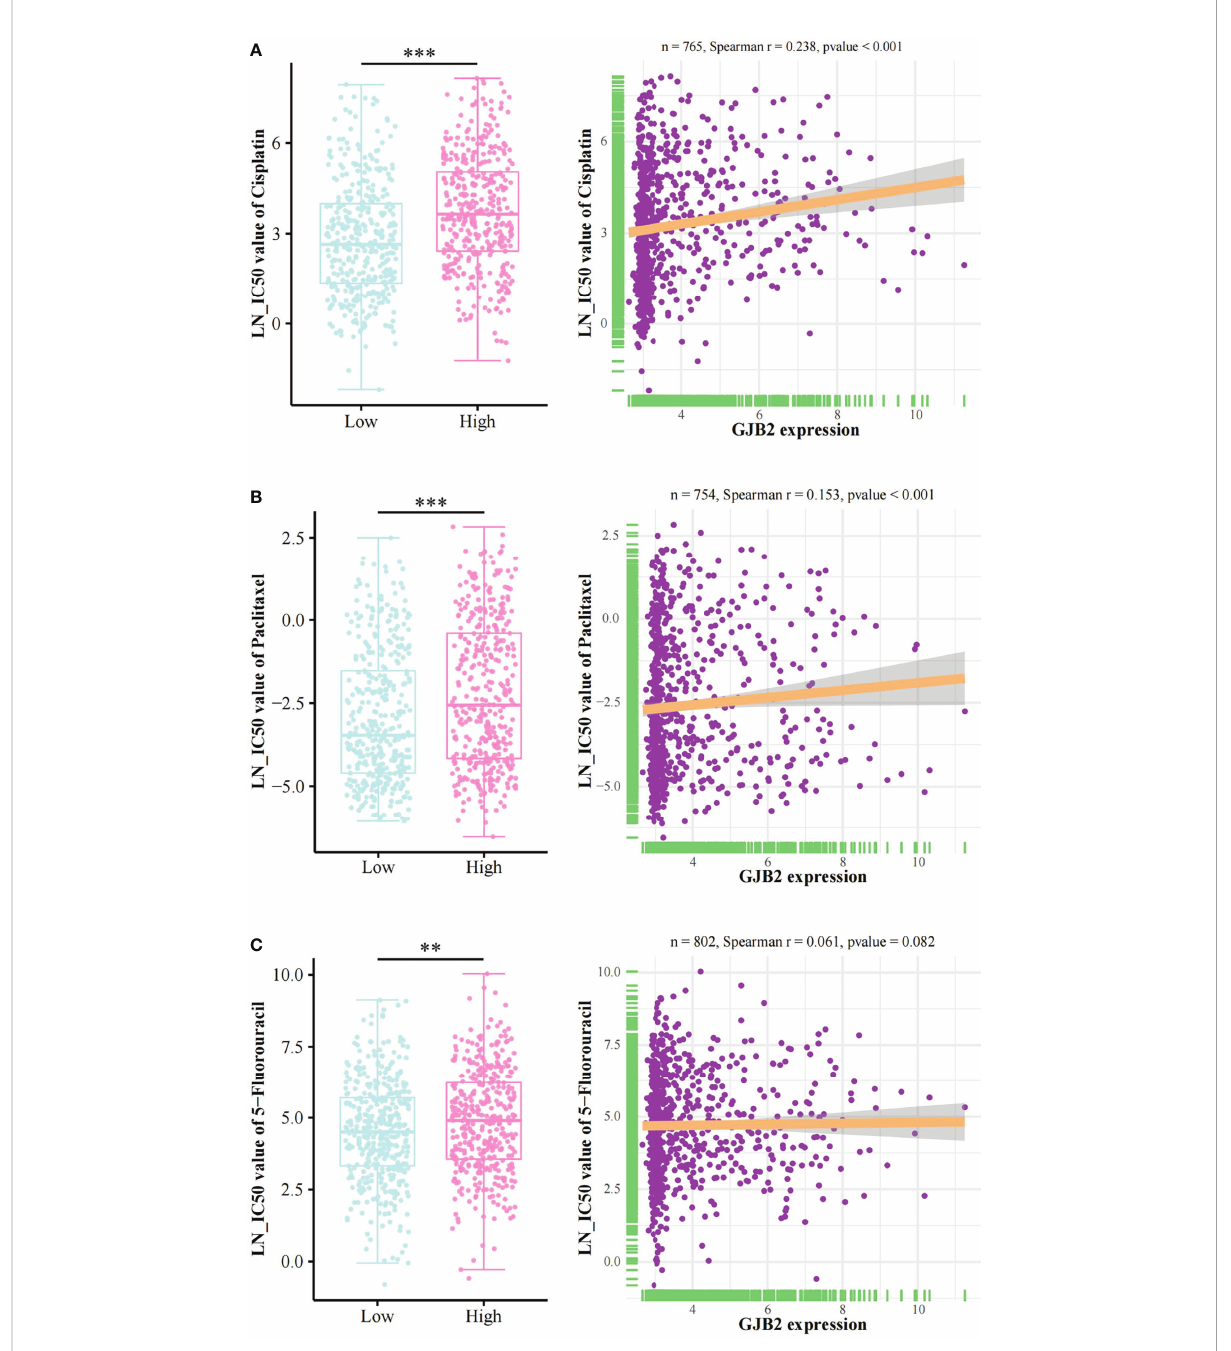
FIGURE 4 Chemotherapy drugs sensitivity analysis. The relationship between GJB2 expression and LN_IC50 values of (A) cisplatin, (B) paclitaxel, and (C) 5- fl uorouracil. LN_IC50 value: Natural log of the half-maximal inhibitory concentration. **p < 0.01, ***p <